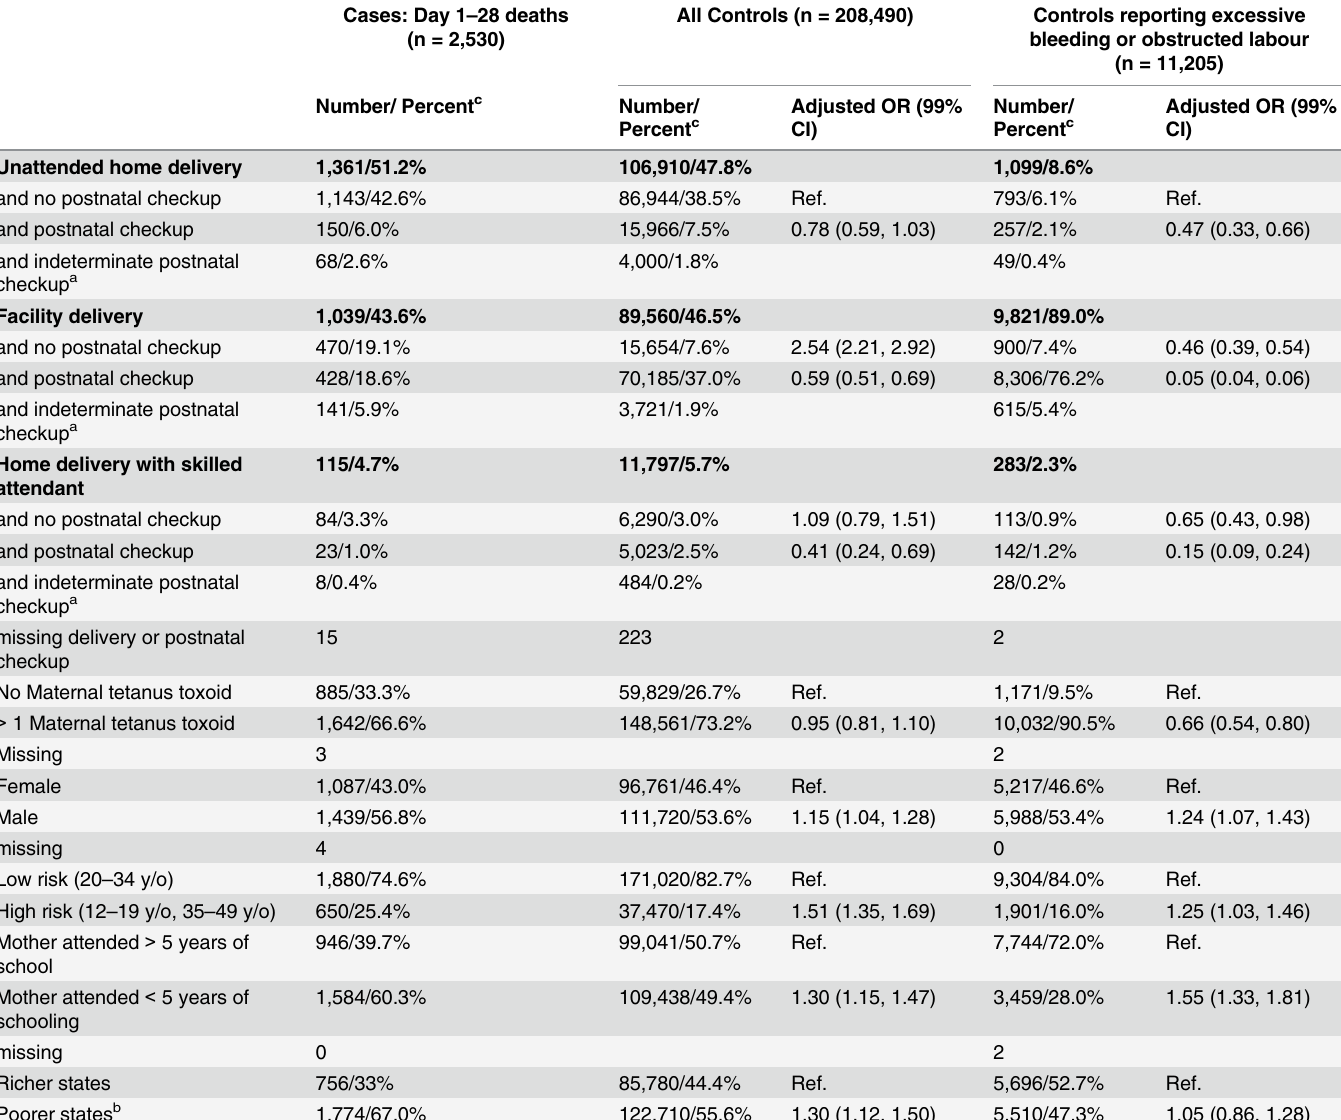
Table 1. Prevalence of exposures and adjusted odds ratios among singleton live births who died or survived the neonatal period by two different controls, India 2004 – 2008. Cases: Day 1 – 28 deaths (n =